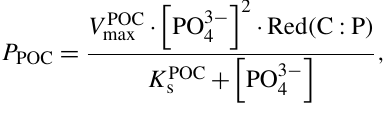
Figure 2. Assumed sensitivities of CaCO 3 export production in re- sponse to changes in calcite saturation ( (cid:127) ). The rain ratio coefficient is used as factor “ a ” applied to the right-hand side of the equation for CaCO 3 production (see Eq. 1). For the control run, a was fixed at each grid point according to the prevailing pre-industrial carbon- ate saturation (following the moderate sensitivity). Blue: moderate sensitivity. Green: linear sensitivity. Red: extreme sensitivity. The shape of the curves would look similar at each grid point; only the pre-industrial crossover point would be